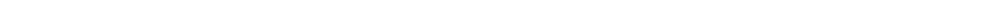
(see fi gure on previous page) Fig. 6 NAC treatment inhibited cell senescence, and TIME signaling mediated the EMT in Bmi-1 − / − cells more than in Bmi-1 − / − p16 − / − AT2 cells. Pulmonary AT2 cells from 7-week-old WT, Bmi-1 − / − , Bmi-1 − / − p16 − / − , and NAC-treated Bmi-1 − / − ( Bmi-1 − / − + NAC) mice. a Representative micrographs of cells stained cytochemically for SA- β -gal. b Percentage of SA- β -gal-positive areas relative to the total. c Second-passage AT2 cell proliferation were determined by CCK-8 assays, and spectrophotometry at 450 nm. Cell number was determined at the indicated hours relative to the cell number at hour 0. d Western blots for SFTPC, α -SMA, pERK1/2 (Thr202/Tyr204), ERK1/2, p16, p53, p21, mature TGF- β 1, IL-11, and Snail. β -actin was used as the loading control. e Protein expression relative to β -actin was assessed by densitometric analysis. f Pulmonary AT2 cells were treated with TGF- β 1 (5 ng/ml, 48 h), TGF- β 1 (5 ng/ml, 48 h), and anti-IL-11 antibody (2 μ g/ml, 48 h), IL-11 (5 ng/ml, 48 h), or IL-11 (5 ng/ml, 48 h) and the MEK inhibitor (PD98059) (10 μ M , 48 h). Western blots for SFTPC, α -SMA, pERK1/2 (Thr202/Tyr204), ERK1/2, p16, p53, and p21. β -actin was used as the loading control. g Protein expression relative to β -actin was assessed by densitometric analysis. h Representative micrographs of cells immuno fl uorescently stained for α -SMA and SFTPC, with DAPI staining the nuclei. i The percentage of α -SMA- or SFTPC-positive areas was relative to the total. j WT AT2 cells treated with CM from third-passage pulmonary fi broblasts from the WT, Bmi-1 − / − , Bmi-1 − / − p16 − / − or NAC-treated Bmi-1 − / − ( Bmi-1 − / − + NAC) groups. k The percentage of α -SMA- or SFTPC-positive areas relative to the total. Six biological replicates were used per experiment. Values are the means ± SEM of six determinations. * P < 0.05, ** P < 0.01, *** P < 0.001 compared with the WT group; # P < 0.05, ## P < 0.01, ### P < 0.001 compared with the Bmi-1 − / − group; & P < 0.05, && P < 0.01 compared with the Bmi-1 − / − p16 − / − group. ^ P < 0.05, ^^ P < 0.01, ^^^ P < 0.001 compared with the vehicle group; + P < 0.05, ++ P < 0.01, +++ P < 0.001 compared with the TGF- β 1 treatment group; @ P < 0.05 compared with